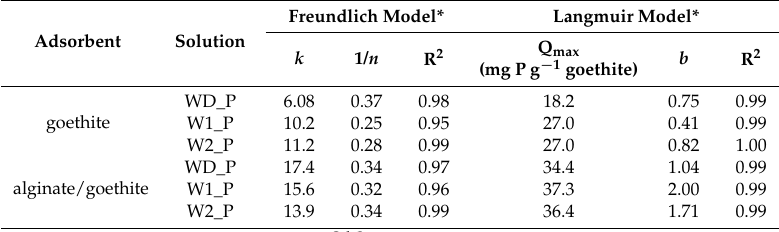
Table 3. Freundlich and Langmuir isotherms constants for phosphate adsorption onto goethite and alginate/goethite capsules.